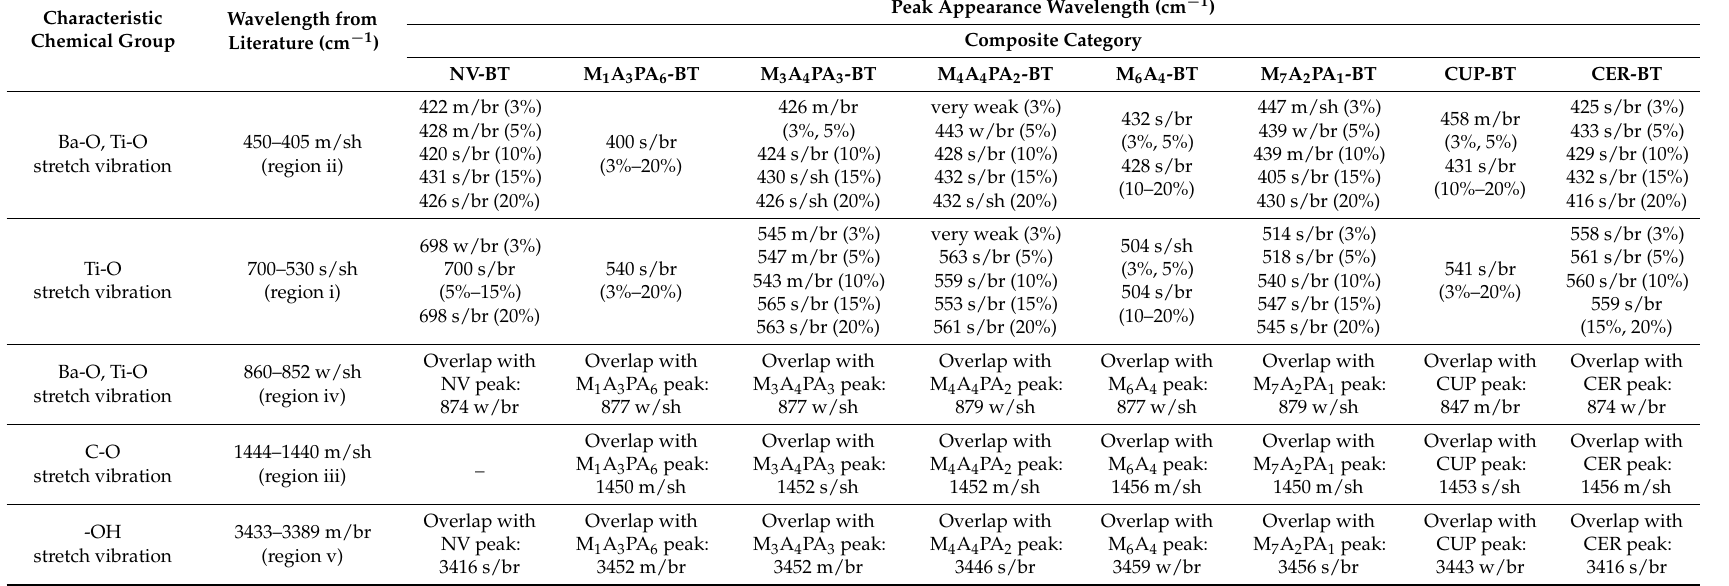
Table 9. FT-IR spectra characteristic peaks from all of the developed